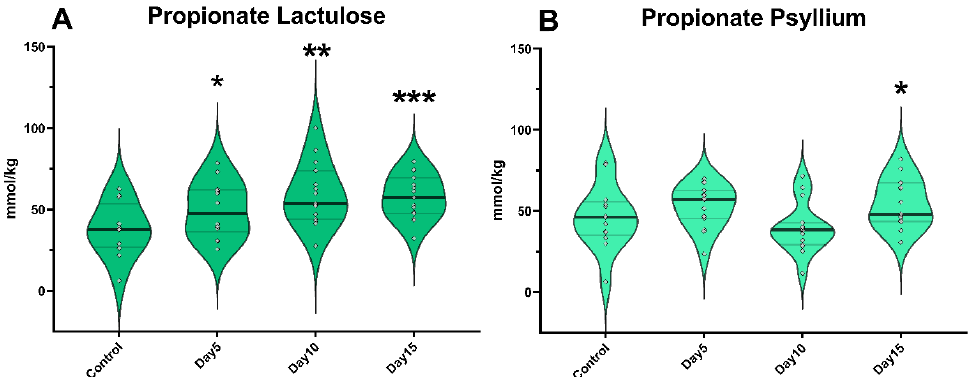
Figure 3. Violin plots show the propionate concentration in the fecal samples following lactulose ( A ) and psyllium ( B ) treatment measured by GC-MS method. Data are visualized using violin plots. Concentrations of single samples are plotted as gray dots; black line refers to the median and gray lines refer to first and third quartiles. * p < 0.05, ** p < 0.01, *** p < 0.001.